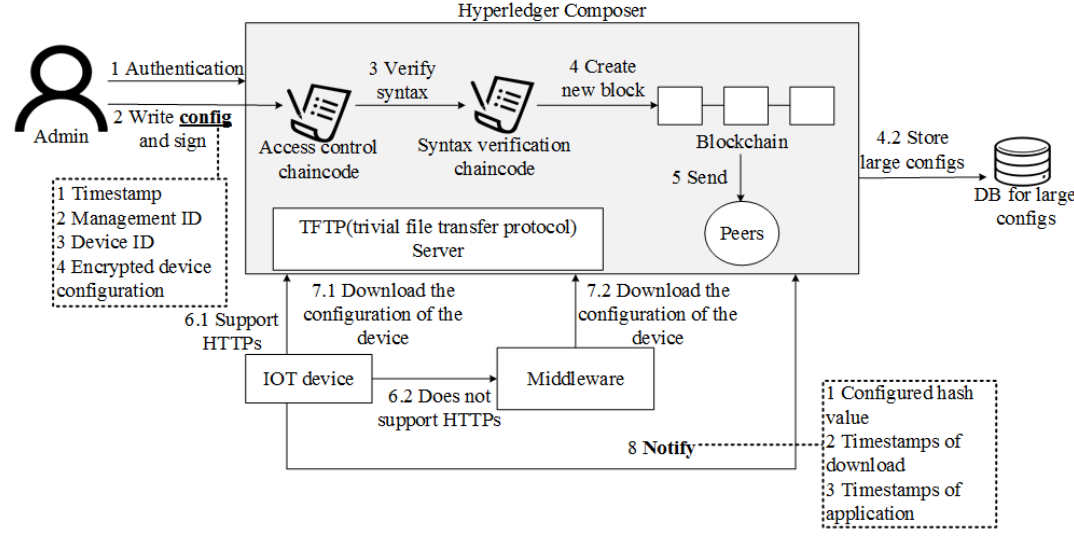
Figure 7. Reconstruction diagram of reference [28].